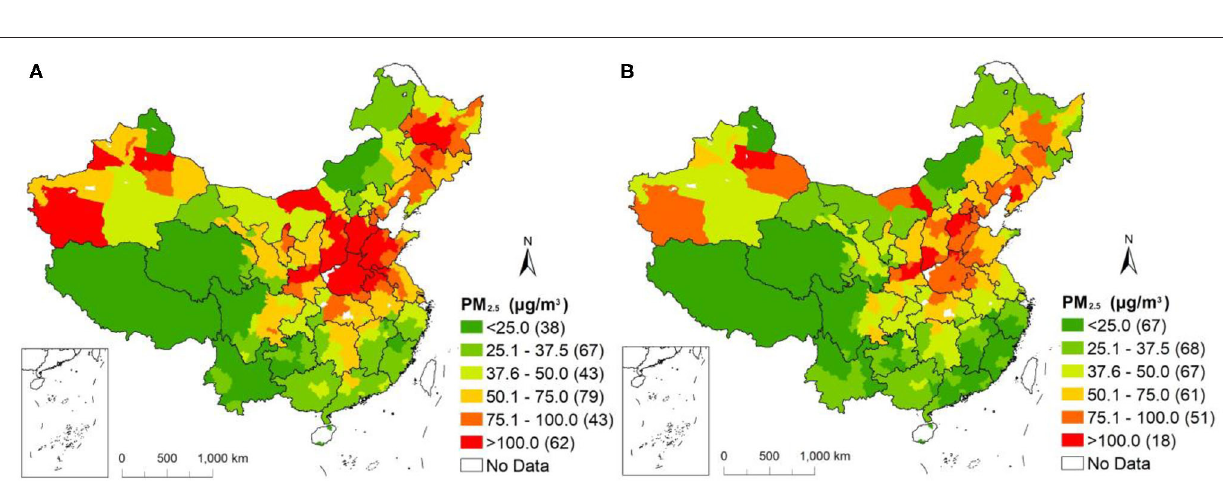
concentrations in most cities were promoted. In contrast, the coefficients of rh, tem and ws were left-distributed, and the peaks emerged at approximately − 0.08, − 1.25, and − 0.25, respectively, revealing that the increase in rh, tem and wind would restrain the raise of PM 2.5 concentration in most cities during our study